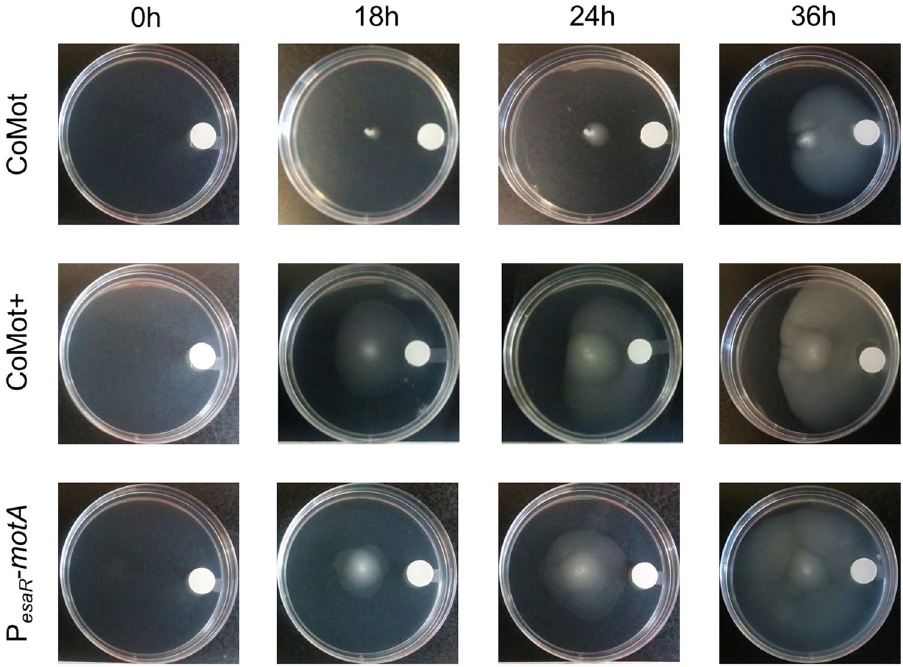
Figure 2. CoMot and CoMot + cells in a 3OC6HSL gradient show directional movement towards the 3OC6HSL source: A 3OC6HSL gradient was established by adding 0.02 μ moles of 3OC6HSL to a Whatmann membrane and allowing it to diffuse for 8 h. 1 μ M of 3OC6HSL would be the final concentration if 0.02 μ moles of 3OC6HSL diffused uniformly through the plate. CoMot, CoMot + or cells that constitutively express motA ( ∆ motA transformed with a plasmid containing P esaR - motA ) were then inoculated at the centre of the plate. Images were obtained following 0, 18, 24 and 36 h of incubation at 30 °C. The assay was run in triplicate for each strain and representative images are